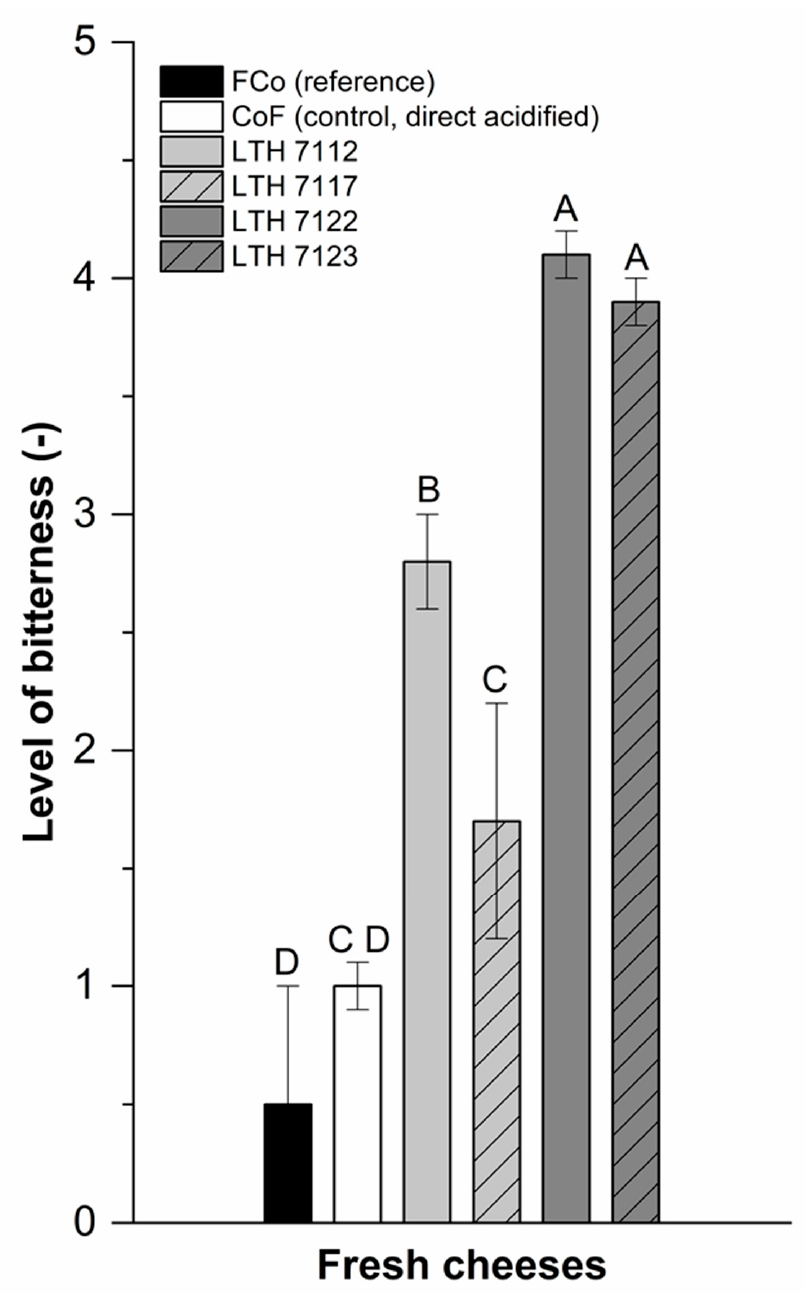
Figure 1. Level of bitterness of fermented-concentrated fresh cheese (FCo, black bar) used as a reference and concentrated-fermented (CoF) fresh cheeses manufactured by fermentation with L. lactis strains LTH 7112 ( prtP -negative), LTH 7117 ( prtP -negative), LTH 7122 ( prtP -positive), LTH 7123 ( prtP-positive ), and without fermentation by direct acidification (CoF, control). 0: not bitter, 1: very slightly bitter, 2: slightly bitter, 3: bitter, 4: very bitter, 5: extremely bitter; A–D: bars with different uppercase letters are significantly different ( p < 0.05). Values represent the means and standard deviations (i = 2, n panelists ≥ 12).